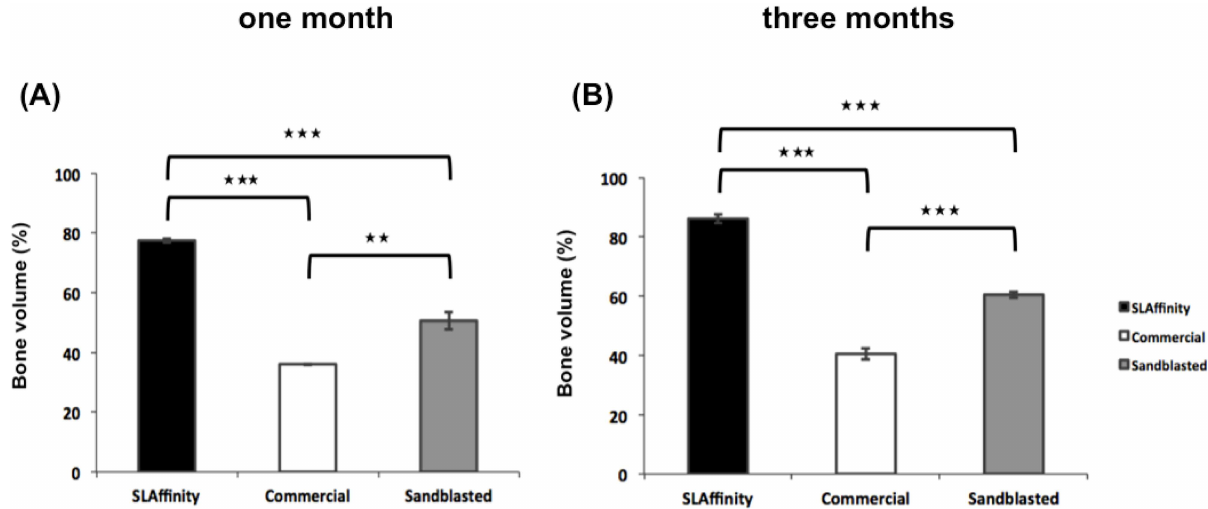
Fig 6. The bone volume of different pedicle screwsinserted into vertebralcolumn after implantation. (A) 1 month and (B) 3 months after implantation. ** : p < 0.01 and *** : p < 0.001.